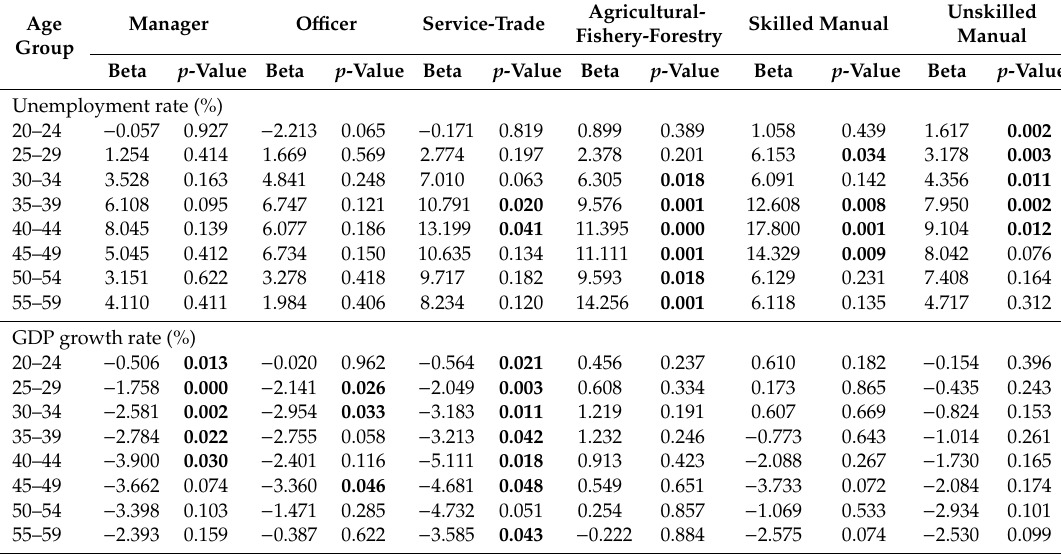
Table 2. Association among unemployment rate, GDP growth rate, and the number of suicides according to occupational